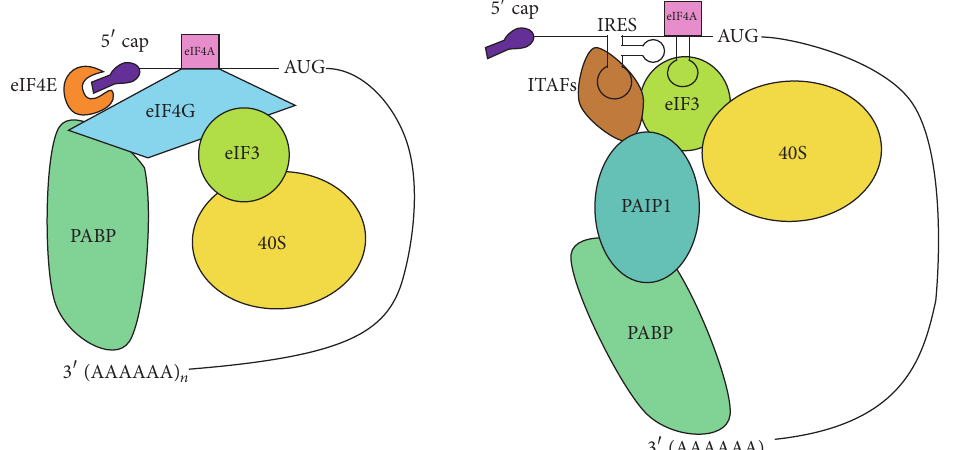
Figure 3: Comparison between cap-dependent and IRES-dependent translation initiation of cellular mRNAs. In cap-dependent translation, initiation complex is formed on the 5 󸀠 end of mRNA with help of several eukaryotic initiation factors (eIFs). eIF4F-complex (eIF4E, eIF4G, and eIF4A) is recruited to the 5 󸀠 m 7 G cap. The key interaction between eIF3 and eIF4G recruits the ribosome to the 5 󸀠 cap. In IRES-mediated translation, initiation complex is formed in the vicinity of the start codon with help of ITAFs and eIFs. For example, XIAP IRES interacts with eIF3 and recruits the ribosome via eIF3-PAIP1-PABP link [12]. IRES: internal ribosome entry site; PABP: poly(A) tail binding protein; PAIP1: PABP interacting protein 1; 40S: 40S ribosomal subunit; AUG: start